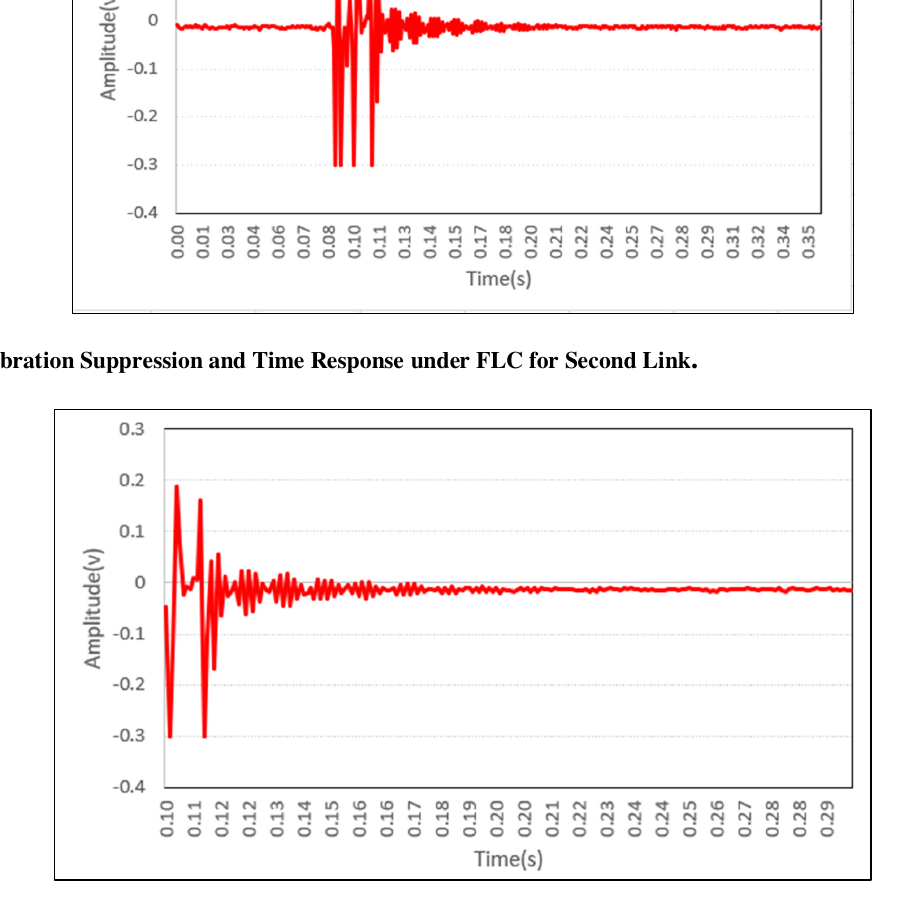
Fig. 12. Zoom in Vibration Suppression and Time Response of Second Link under